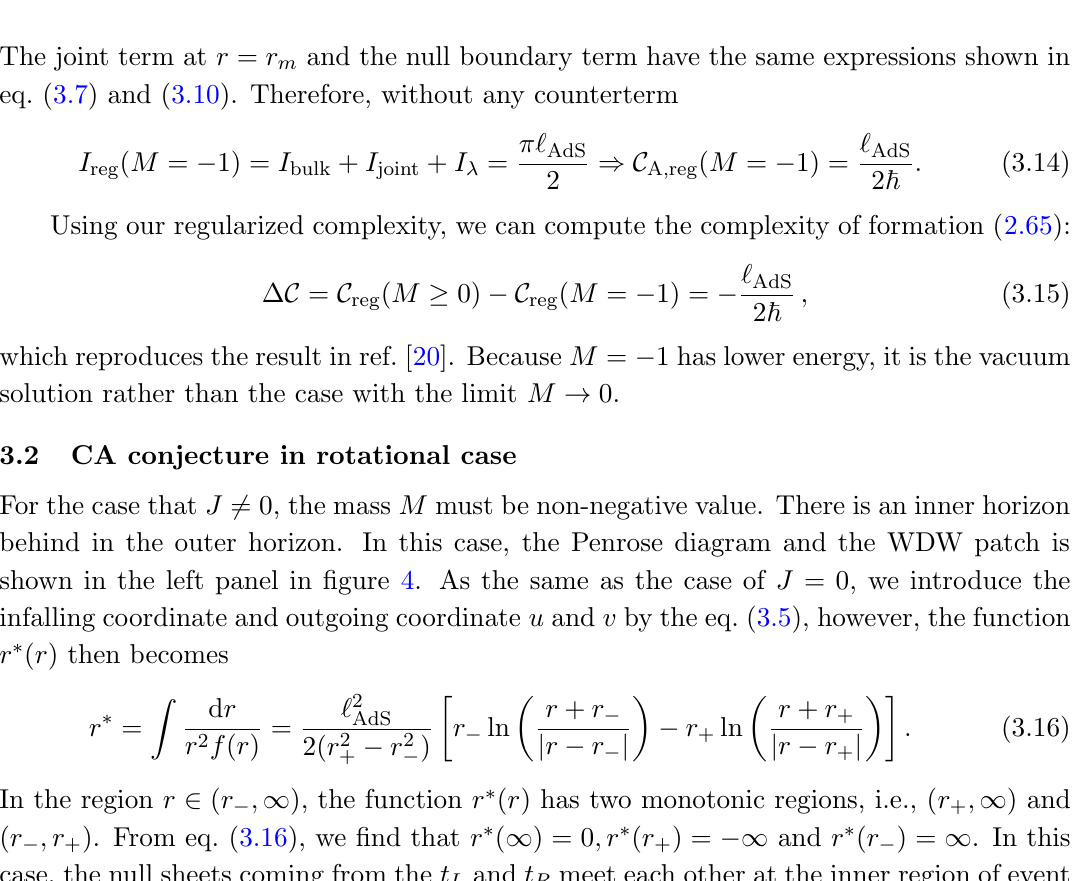
Figure 4 . The WDW patch in the Penrose diagram (left panel) and the Kruskal-type coordinate (right panel) for the rotational BTZ black hole. The null sheets coming from t R = t L = 0 meet each other at the surface r = r 0 2 ( r (cid:0) ; r +